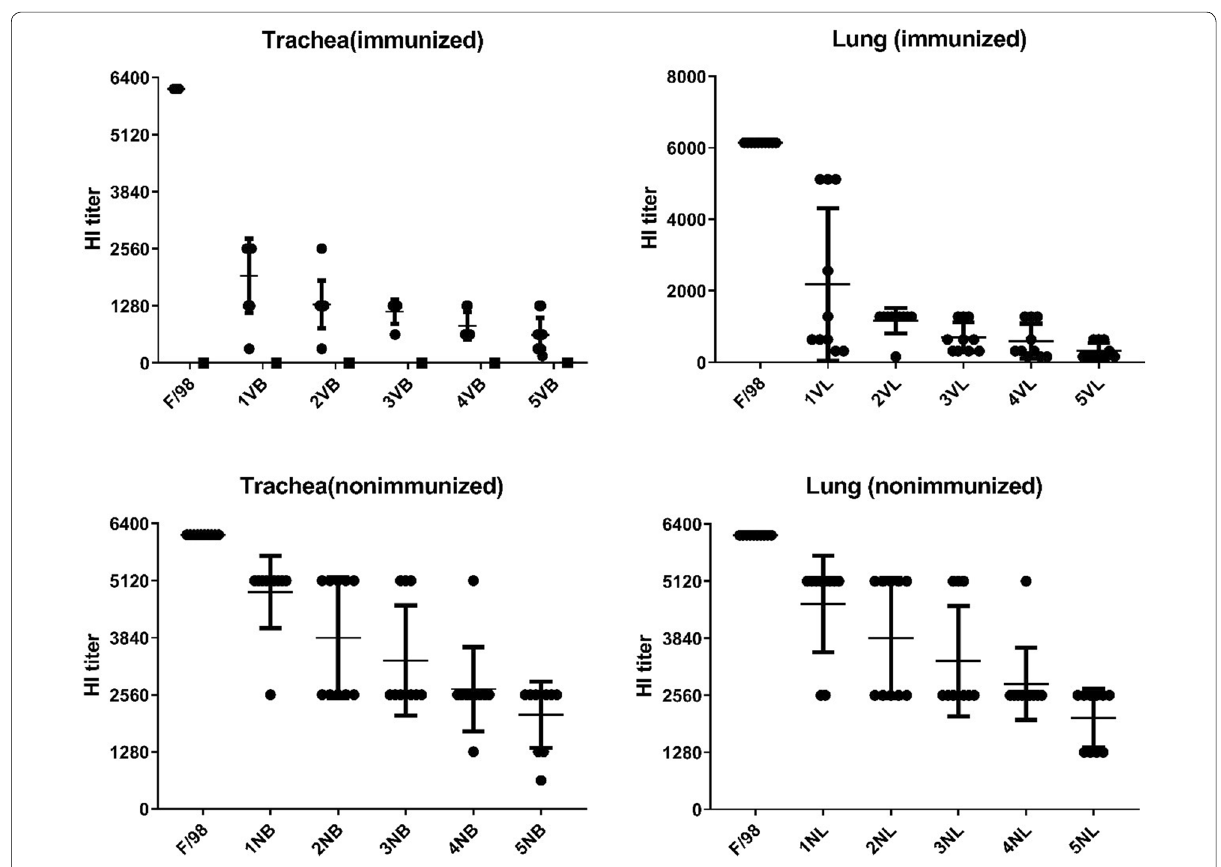
Fig. 2 F/98 virus antigen variation under antibody